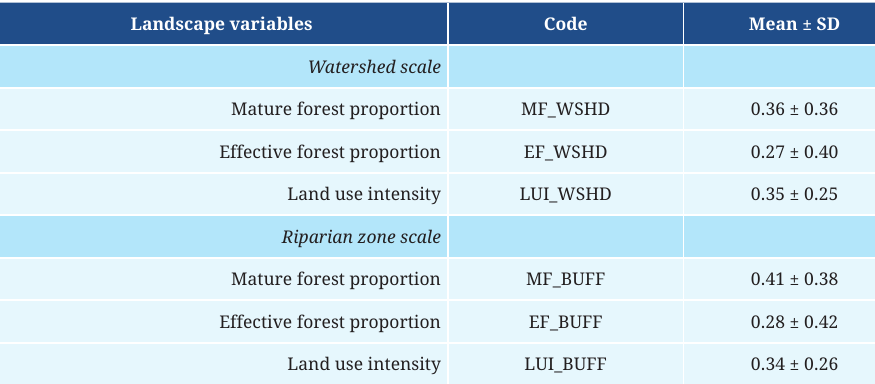
TABLE 3 | Summary of landscape variables at the watershed and riparian zone scales (mean ± standard